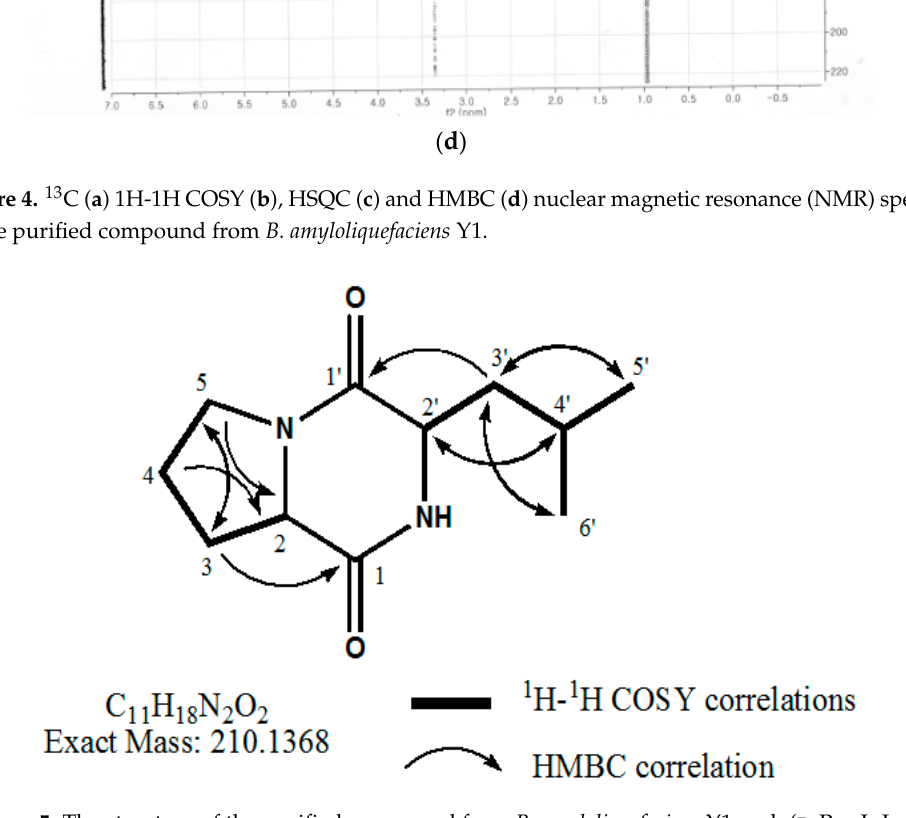
Figure 5. The structure of the purified compound from B. amyloliquefaciens Y1 cyclo( D -Pro- L -Leu).